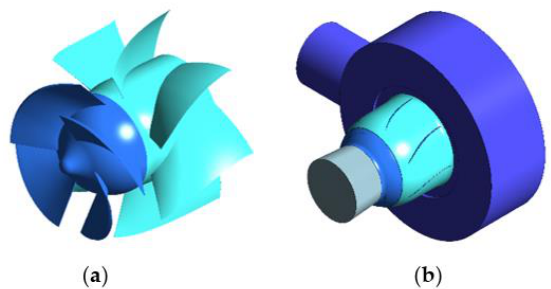
Figure 1. Mixed-flow pump model. ( a ) Impeller and guide vane, ( b ) Calculation domain water body.